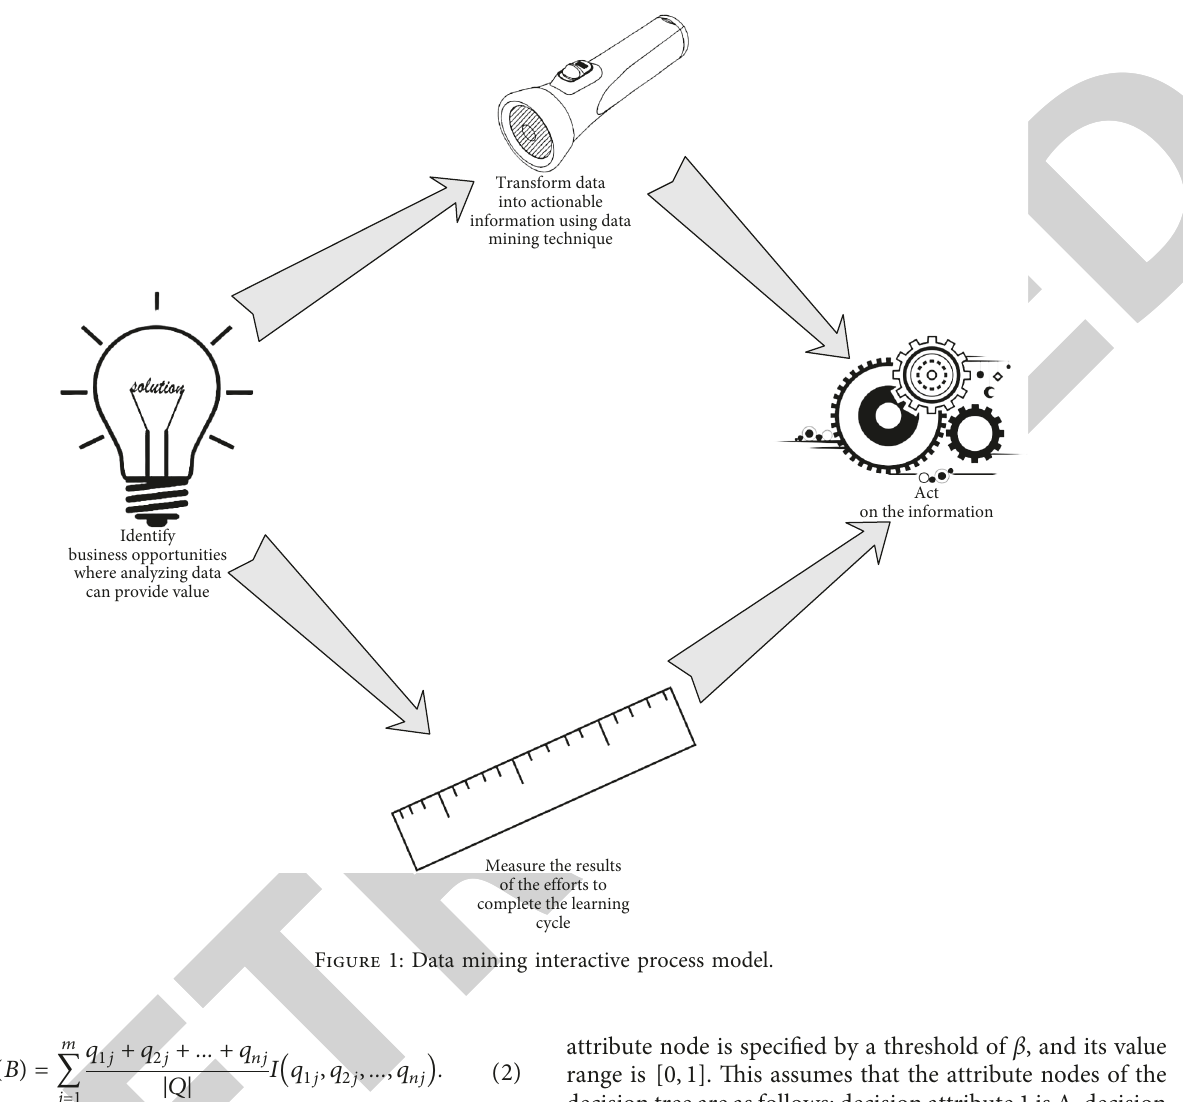
Figure 1: Data mining interactive process